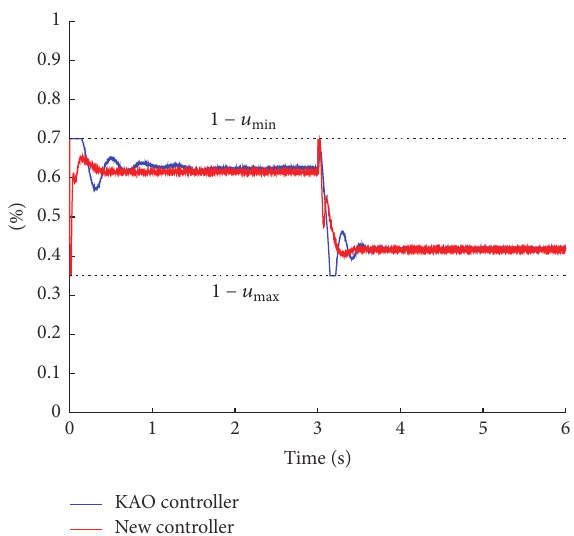
Figure 7: Experimental results: duty cycle percentage 𝑢(𝑡) obtained with the KAO controller (56) and for the new controller in (60).